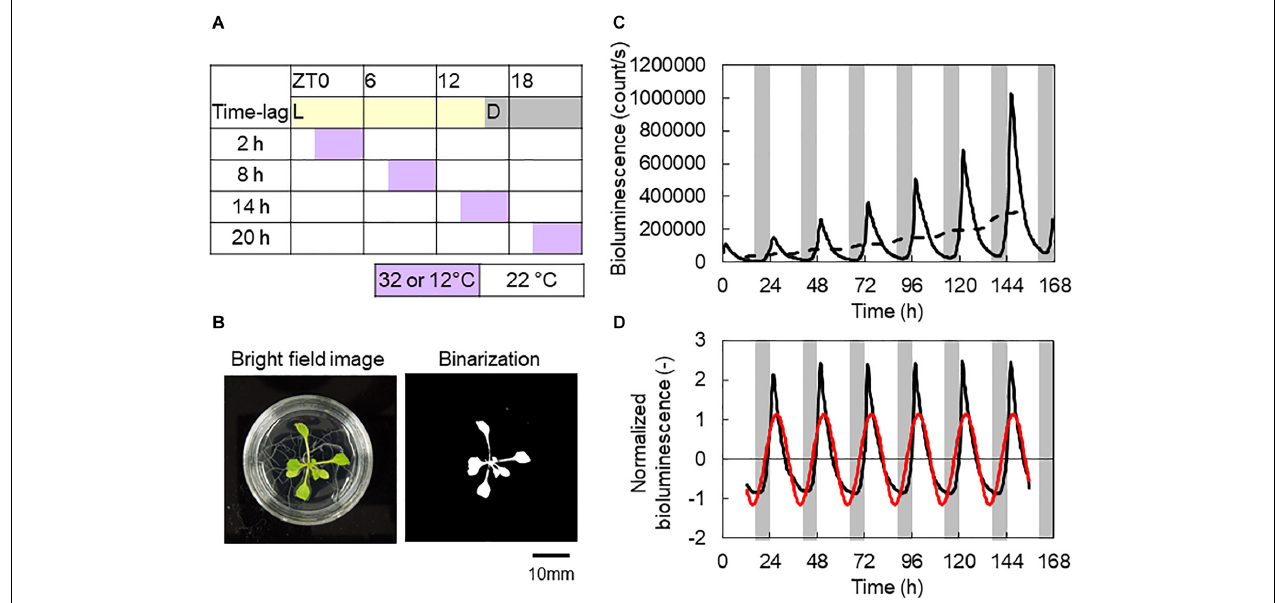
FIGURE 1 | Experimental conditions and representative analysis data. (A) Time table of L/D = 16/8 h and 4 h ± 10 ◦ C conditions. (B) Bright-field and binarization images of an Arabidopsis thaliana seedling. Projected leaf area (PLA) measured by banalization of the areal part. (C) Bioluminescence of a CCA1::LUC seedling. Solid and broken lines are raw data and its moving average, respectively. (D) Normalized bioluminescence (black line) and the first Fourier series (red line). Data were from control conditions with in-phase initial conditions (B–D) .